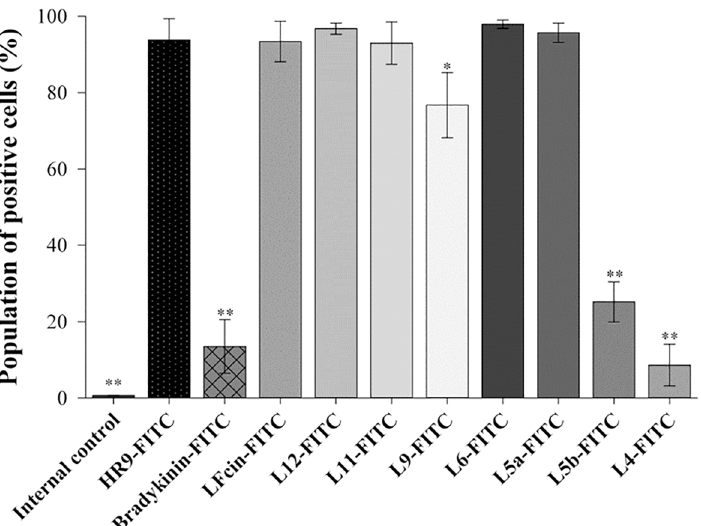
Fig 1. Cellular internalization of eight LFcin derivatives. Cells were treated with 10 μ M FITC-labeled LFcins for 1 h. The fraction of cells internalizing the LFcin was determined by flow cytometry. Statistical comparisons were performed by ANOVA. Significant differences from the uptake of HR9-FITC at P < 0.05 ( * ) and P < 0.01 ( ** ) are indicated. Data are presented as mean ± SD from seven independent experiments in each treatment